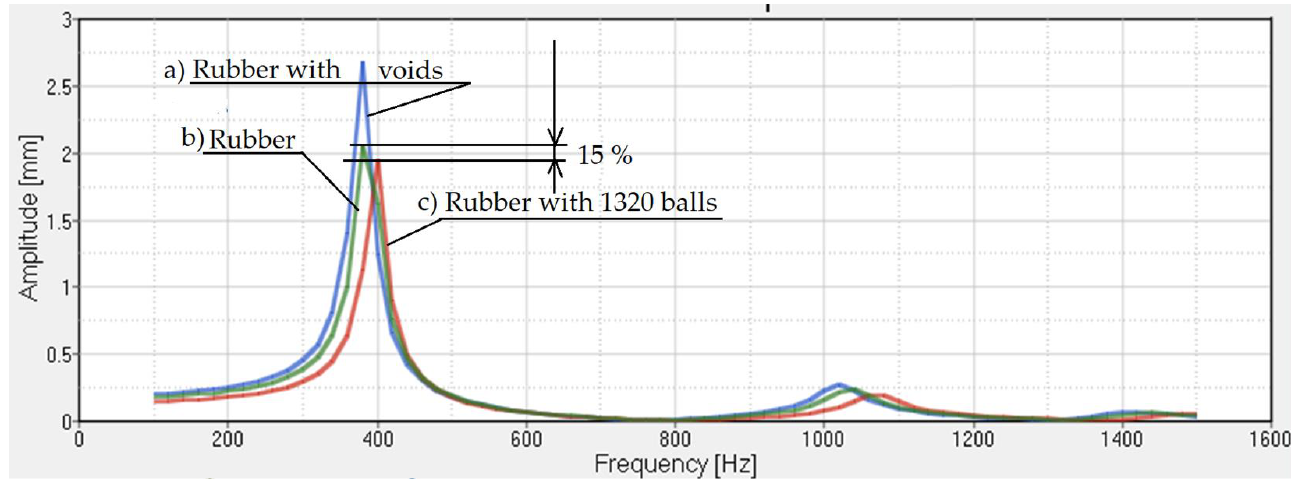
Figure 9. Transmissibility for: ( a ) rubber with voids; ( b ) rubber; and ( c ) rubber with steel balls. The structural damping is 6%.